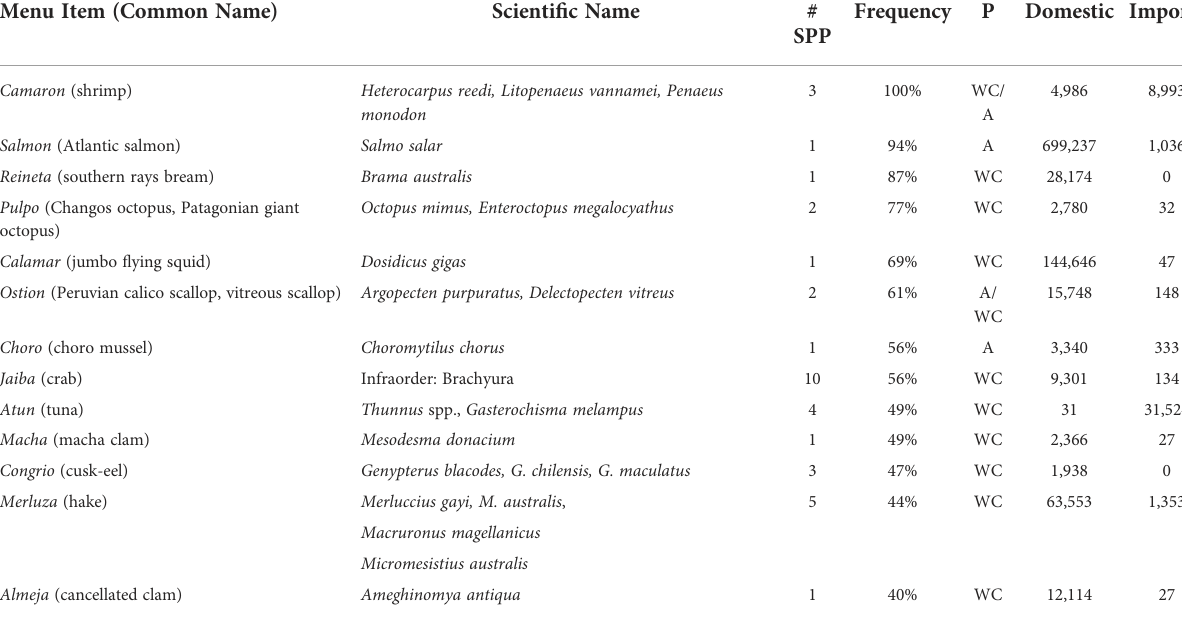
TABLE 3 The thirteen most common seafood products that were present on restaurant menus in